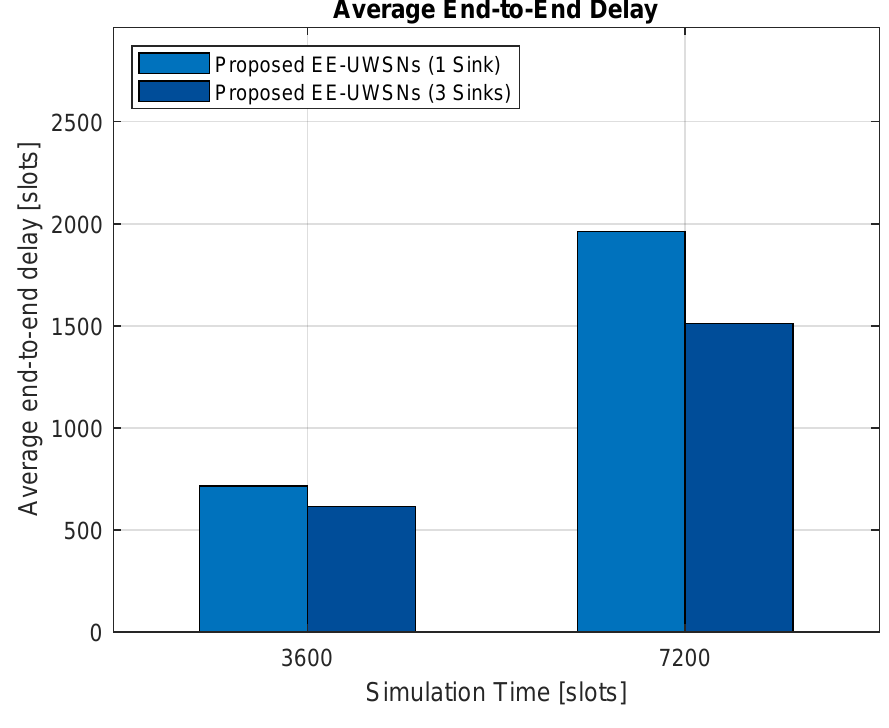
Figure 18. The effect of changing the number of sinks on end-to-end delay.